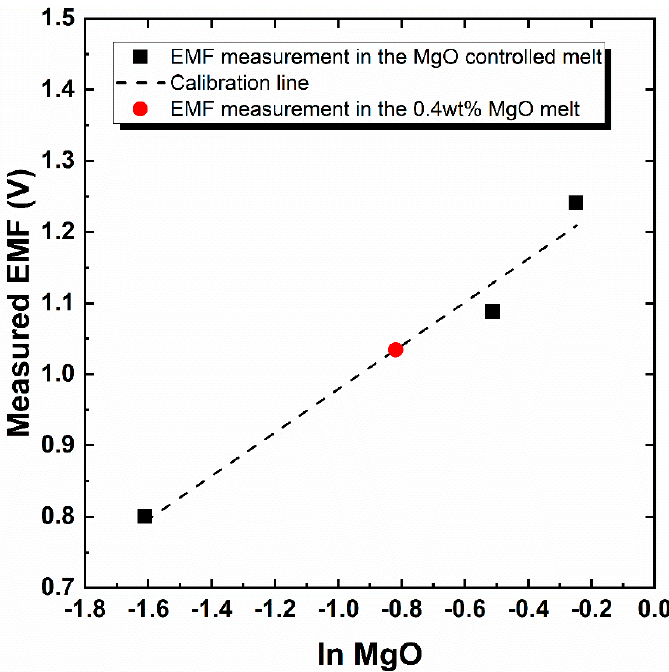
Figure 6. Relationship between the measured EMF and logarithm of MgO concentration. The black dashed line is the calibration line used for predicting MgO concentration from the measured EMF.